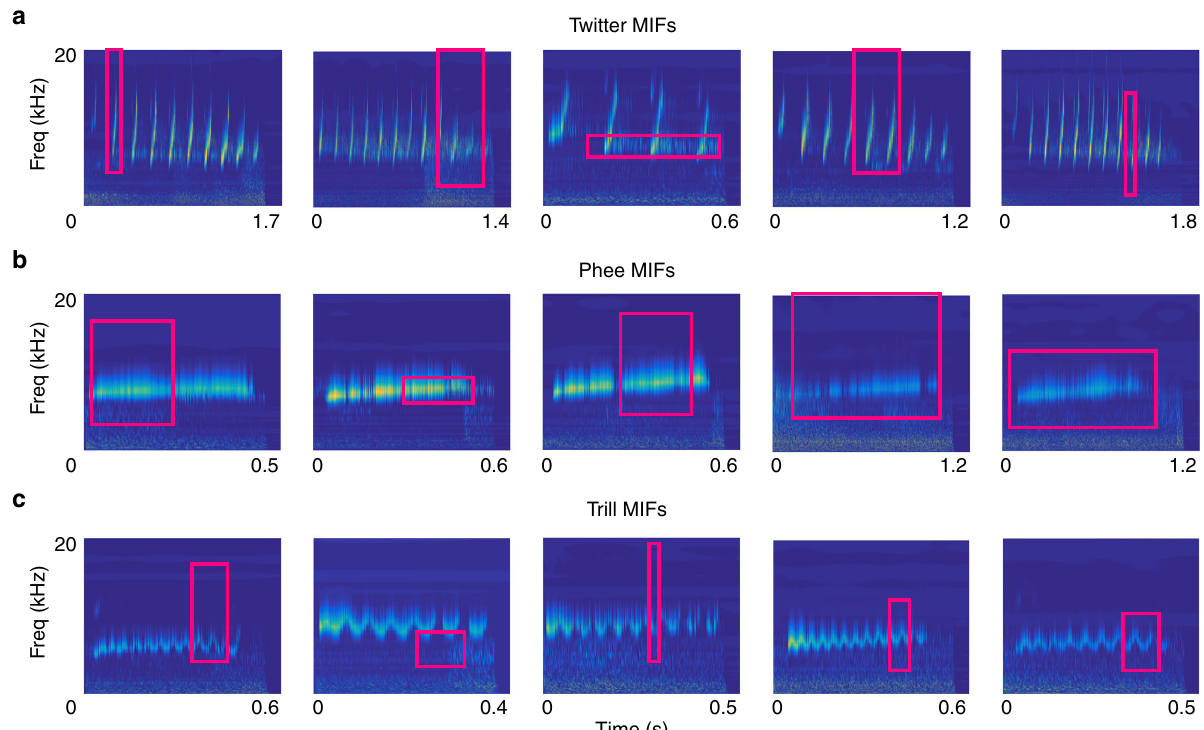
Fig. 3 Most informative features for the classi fi cation of marmoset calls. Magenta boxes correspond to MIFs for the classi fi cation of a twitters vs. all other calls, b phees vs. all other calls, and c trills vs. all other calls, overlaid on the cochleagrams of the parent calls from which the MIFs were obtained